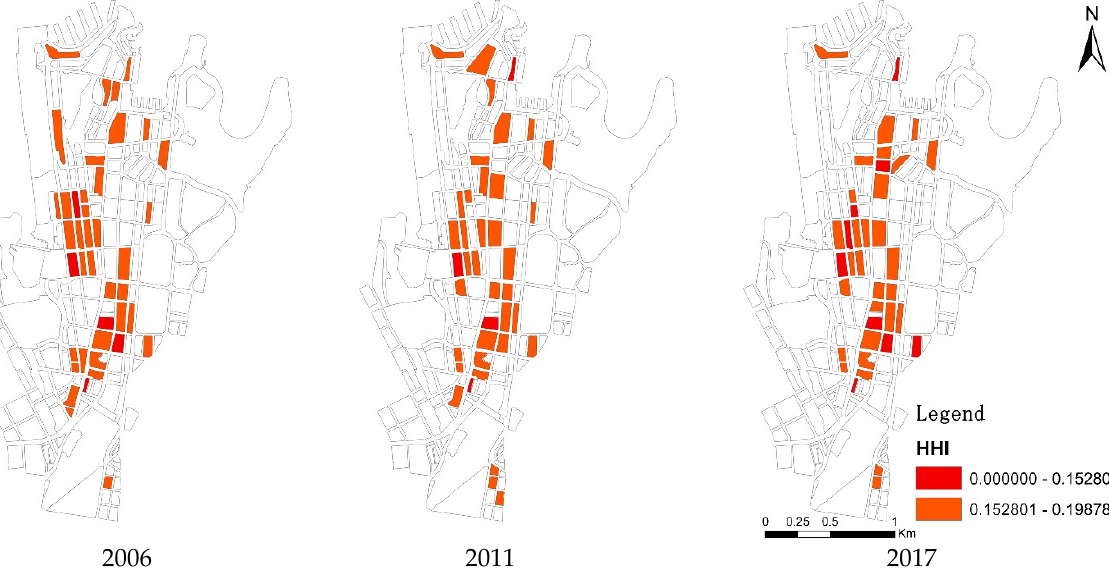
Figure 4. Time–series analysis of highly heterogeneous urban blocks.